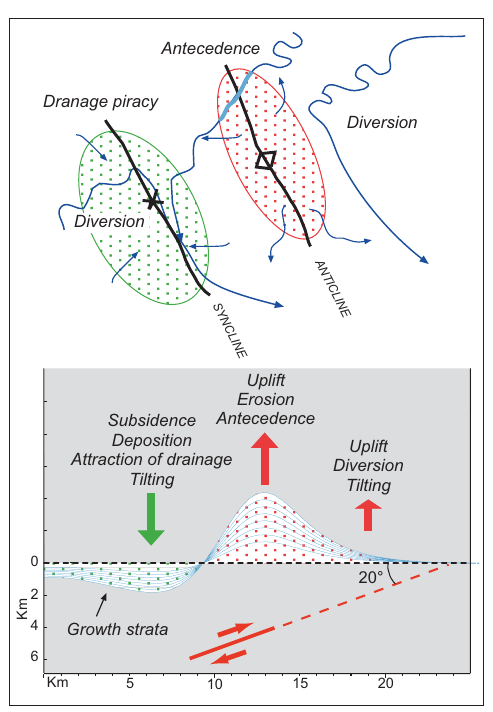
Fig. 3. Schematic representation in map view (abo- ve) and cross-section (below) of the effects that slip on a generic blind, low-angle thrust fault may have on geomorphic/sedimentary processes. The vertical component of the expected deformation is related to the fault’s geometry and kinematics through the elas- tic dislocation theory. Evolution of sedimentation and drainage pattern over a wide area is controlled by the growth of the anticline/syncline, which produces tilting of the ground